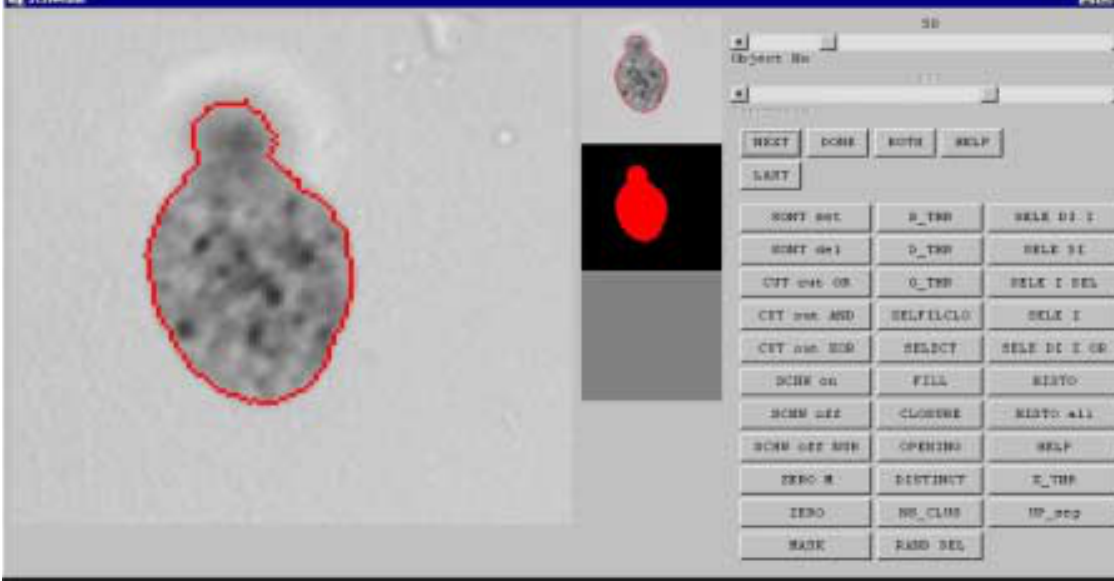
The result of the segmentation will for each object be a mask which we will denote O . It is the set of all pixels p = ( x , y ) of the object O ( p ∈ O ). We also de- fine C ⊂ O as the ordered set of pixels of the contour or border and | · | the number of elements of a set · . In other words O describes the mask or zone of measure- ment and C its border e.g., as a list of coordinates. In Fig. 3 some typical cell images with overlaid borders are displayed. All further measurements are related to those